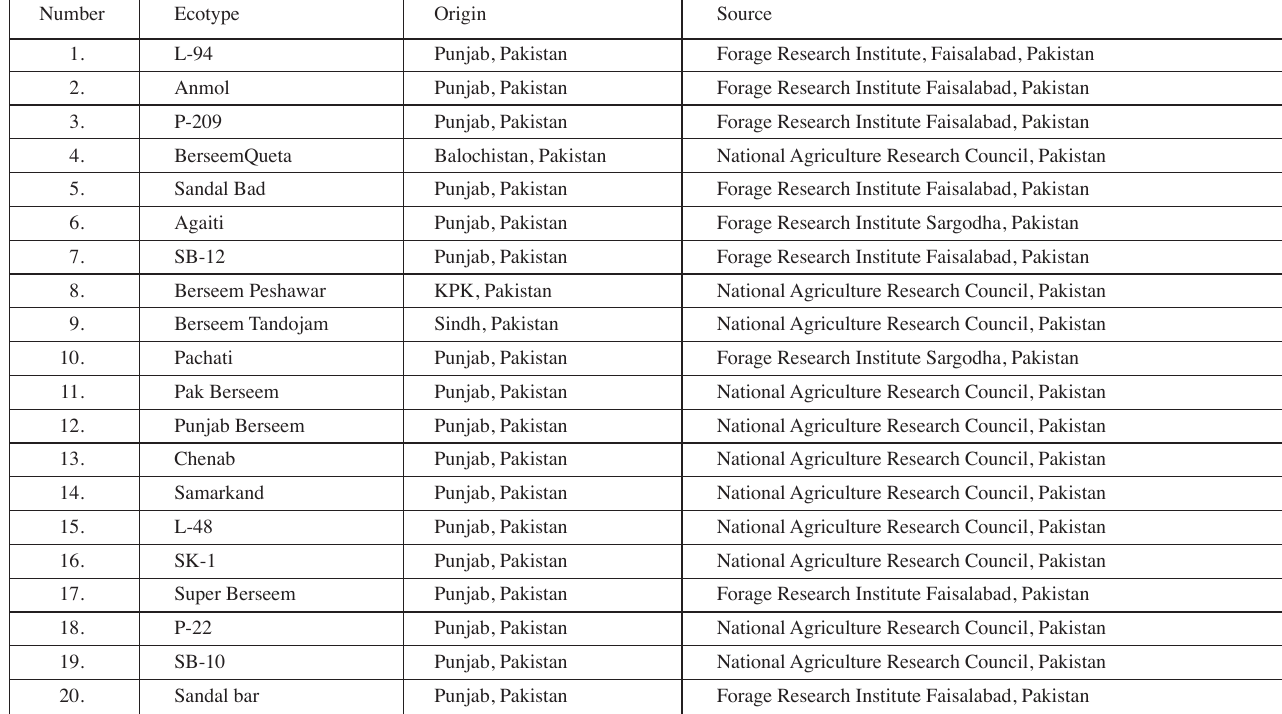
Tab. 1: List of ecotypes of berseem clover ( Trifolium alexandrium L.) used in the